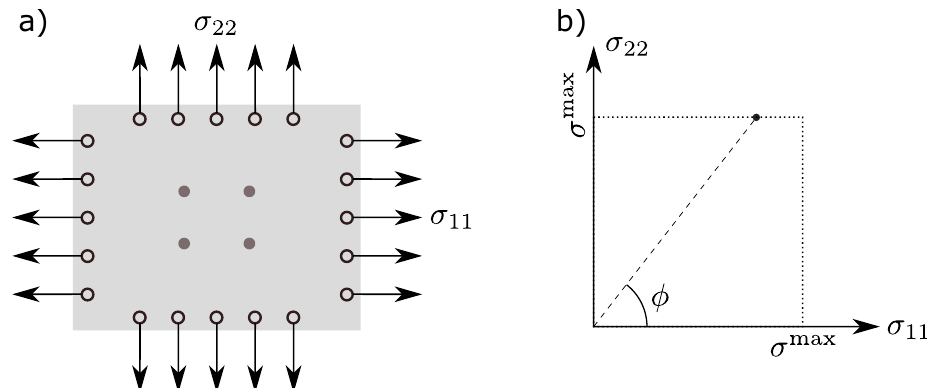
Figure 1. ( a ) A schematic of a biaxial experimental setup in which a thin planar tissue sample (in light gray) is mounted via rakes and two orthogonal forces are applied to induce stresses σ 11 and σ 22 , and the resulting strains are measured by tracking the locations of the markers (in dark gray). ( b ) The σ 11 σ 22 space, where the applied stresses lie on the dotted line with a finite number of protocol − angles φ